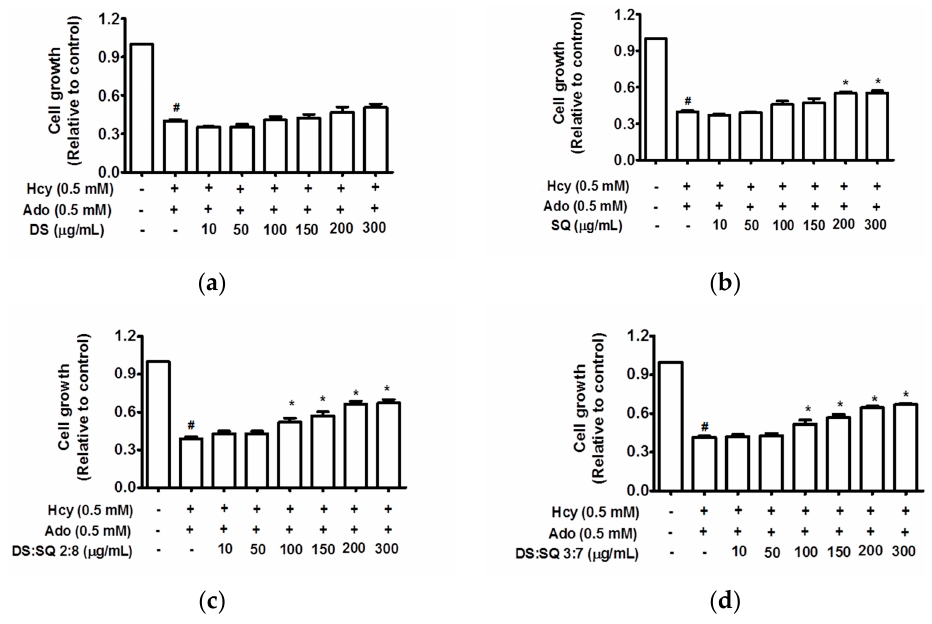
Figure 1. Cell growth (relative to control) concentration curves for DS ( a ), SQ ( b ), DS-SQ 2:8 ( c ) and DS-SQ 3:7 ( d ) aqueous extracts on cell proliferation assay. # p < 0.05 compared with blank control (no Hcy or Ado); * p < 0.05 compared with Hcy and Ado stimulation.